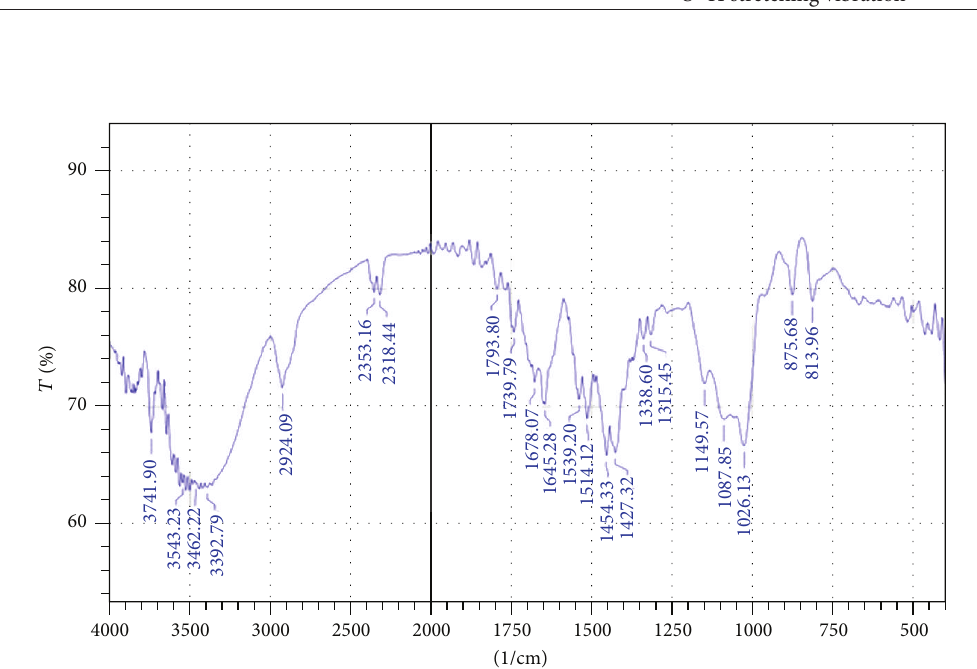
Figure 4: FTIR spectrum of the S. tora polysaccharide (initial sample).